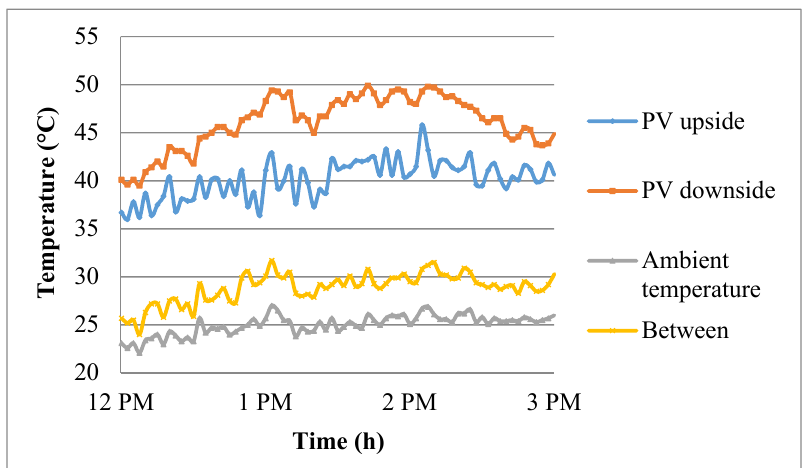
Figure 10. Time dependencies of monocrystalline photovoltaic module parts temperatures, ambient temperature, and temperature between the PV module and roof sheet.